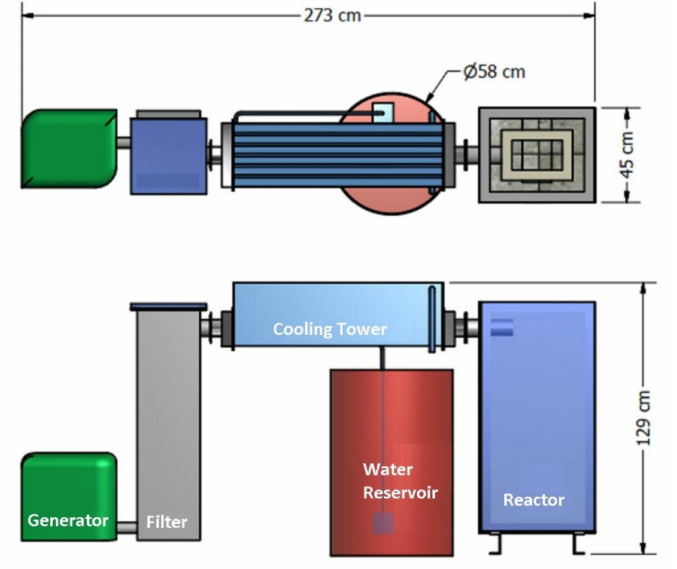
Figure 2. A 3D design of the power plant with palm oil empty fruit bunch as fuel to produce